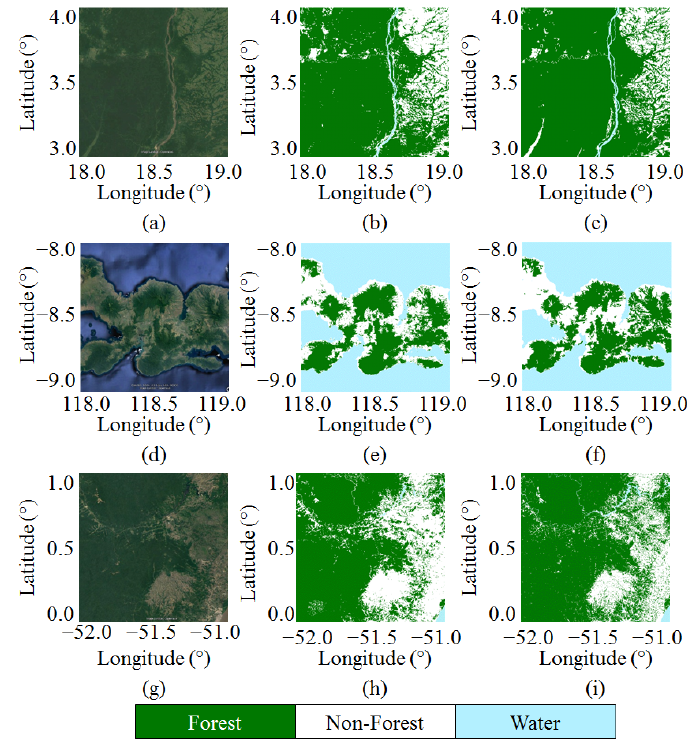
Figure 12. Large-scale mosaics intercomparison for different geocells. Top: Geocell N03E018 in Central Africa: ( a ) Google Earth ©, ( b ) TanDEM-X 2011 and ( c ) PALSAR 2010. Middle: Geocell S09E118 in South-East Asia: ( d ) Google Earth ©, ( e ) TanDEM-X 2013 and ( f ) PALSAR 2015. Bottom: Geocell N00W052 in Amazonas: ( g ) Google Earth ©, ( h ) TanDEM-X 2016 and ( i ) FROM-GLC